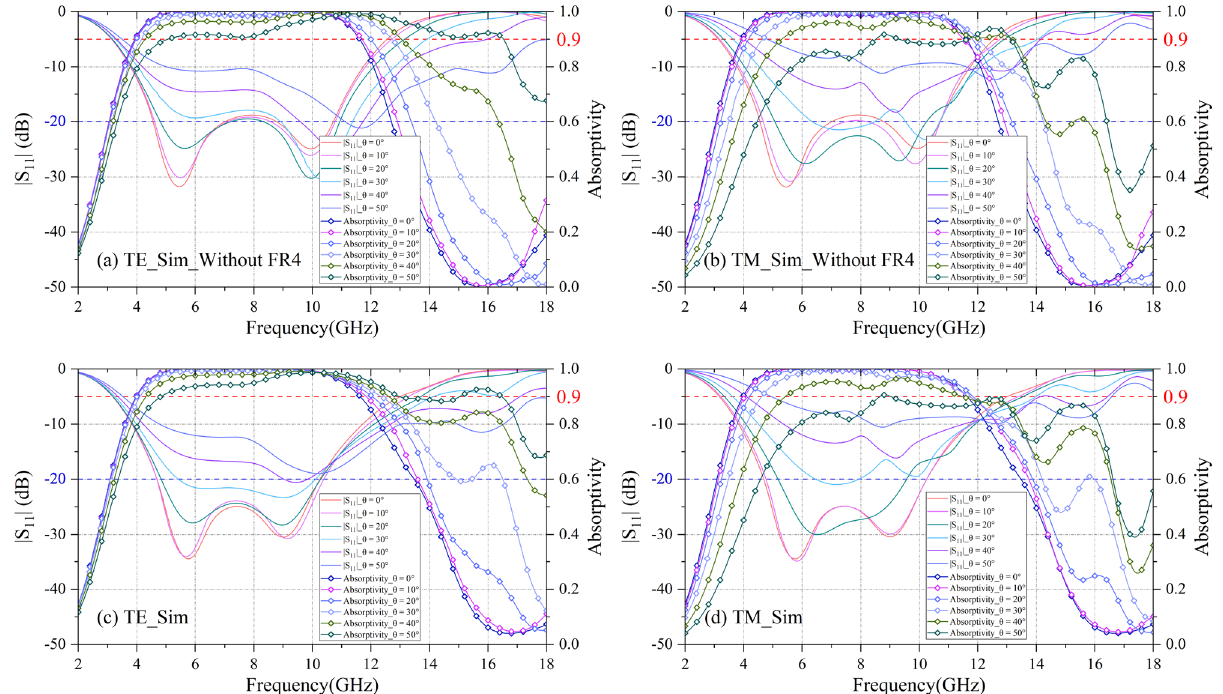
Figure 5. Simulation results of reflection coefficients and absorptivity under different oblique incidences of the proposed CA absorber with/without FR4 superstrate. P = 22.0 mm, Rad_out = 9.0 mm, Rad_in = 6.0 mm, w = 0.5 mm, h 1 = 0.30 mm, h 2 = 2.50 mm, h 3 = 0.13 mm, h 4 = 8.50 mm, R out = 140 Ω, R in = 120 Ω. ( a ) TE-polarization without FR4 superstrate; ( b ) TM-polarization without FR4 superstrate; ( c ) TE-polarization with FR4 superstrate; ( d ) TM-polarization with FR4